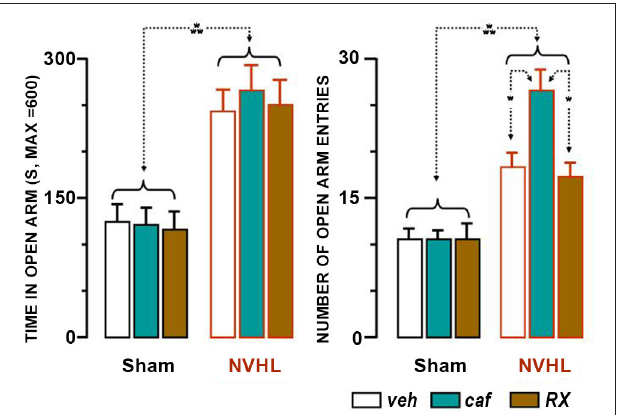
FIGURE 4 | Results of the Plus Maze Test . Presence of the rats in open arms is shown in the left bar graph, and number of entries into the arms in the right bar graph. Each bar represents the mean + S.E.M. The groups of drugs and rats are similar to those described in Figures 2, 3 . The white bars represent the effect of the vehicle, the green ones that of caffeine and the brown ones those for RX821002. The dotted lines ending with two arrows indicate the differences between the groups that were statistically significant (* p < 0.05; *** p <